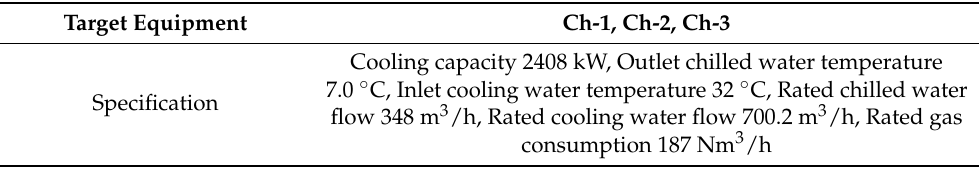
Table 2. Specifications for gas absorption chiller-heater.